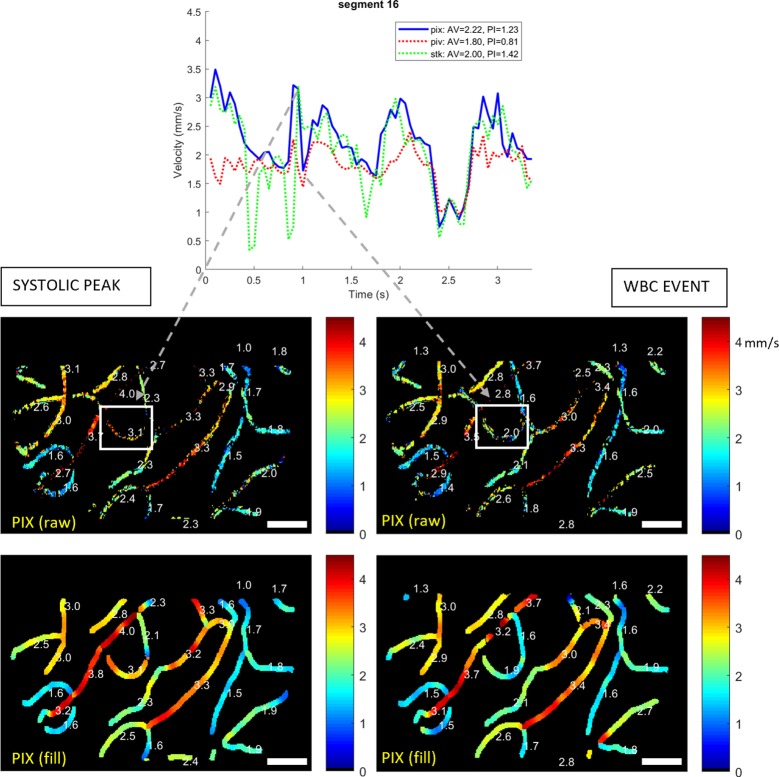
Influence of a white blood cell on capillary velocity.Top: Velocity trace for one segment showing long-term and short-term fluctuations in velocity captured with the PIX algorithm. Arrows indicate a rapid drop from the presumed systolic peak at ~ 3 mm/sec to ~2 mm/sec, which occurs due to passage of a white blood cell. Bottom: PIX velocity maps corresponding to the time points indicated by arrows. White boxes: the vessel segment plotted whose average velocity is plotted in top. Raw and mean-subtracted sequence can be viewed in S3 Video, and evolution of velocity maps in time can be viewed in S4 Video. White boxes indicate the vessel whose average velocity is plotted top. The legend shows, from left to right, the average velocity (AV), the pulsatility index (PI, defined as (max-min) / mean), the R2 goodness of fit to manually tracked data, and the root-mean-square (RMS) residual error to manually tracked data. Scale bars show 50 μm.